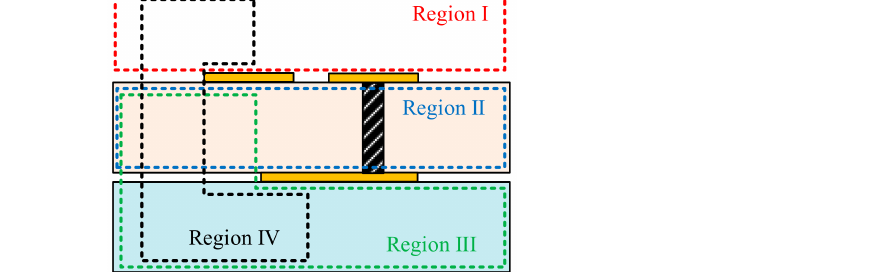
Figure 5. Cross-sectional model of the two-layered CPS-to-MSL transition with four analysis regions. Region I, where the field lines are distributed in the air, is the upper half-plane of the CPS, resulting in the line capacitance C 1 expressed in Equation